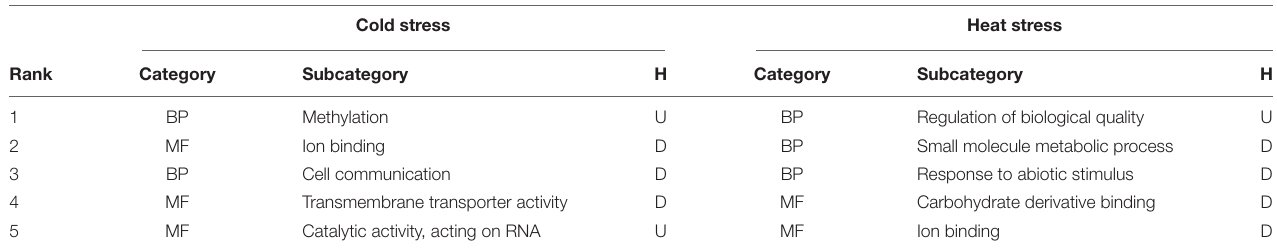
TABLE 3 | Comparison of the top five subcategories with the largest significant difference between the percentages of the upregulated and downregulated genes in Biecheleriopsis adriatica under cold and heat stress in Gene Ontology (GO) functional classification level